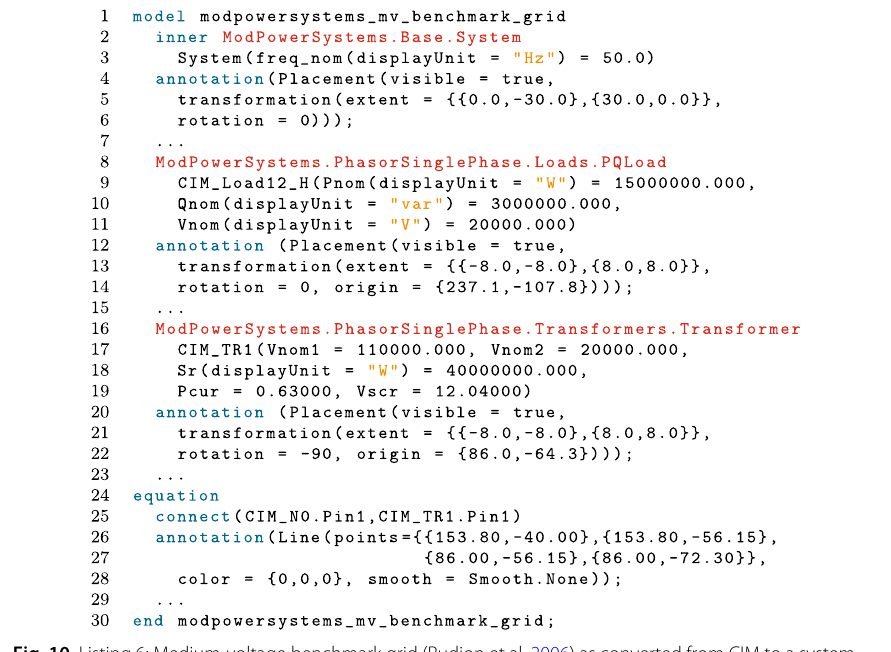
Fig. 10 Listing 6: Medium-voltage benchmark grid (Rudion et al. 2006) as converted from CIM to a system model based on the ModPowerSystems library